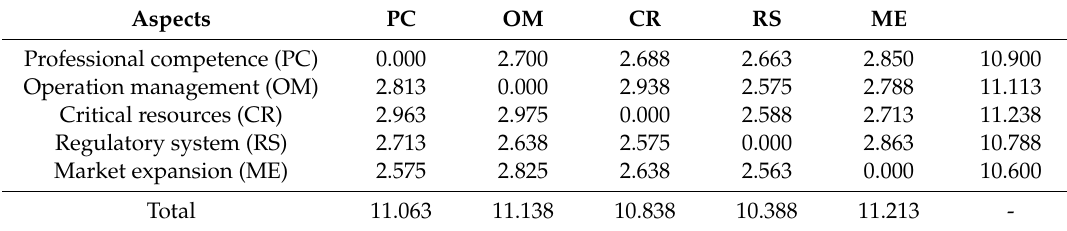
Table 4. The original average influence matrix